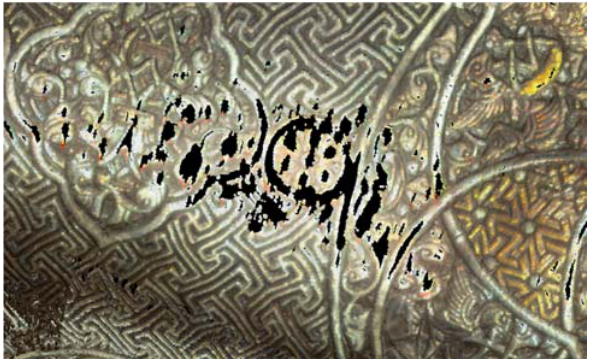
Figure 2. ‘Holes’ in the point cloud produced by the Arius 3D scanner in curved regions of high specularity.